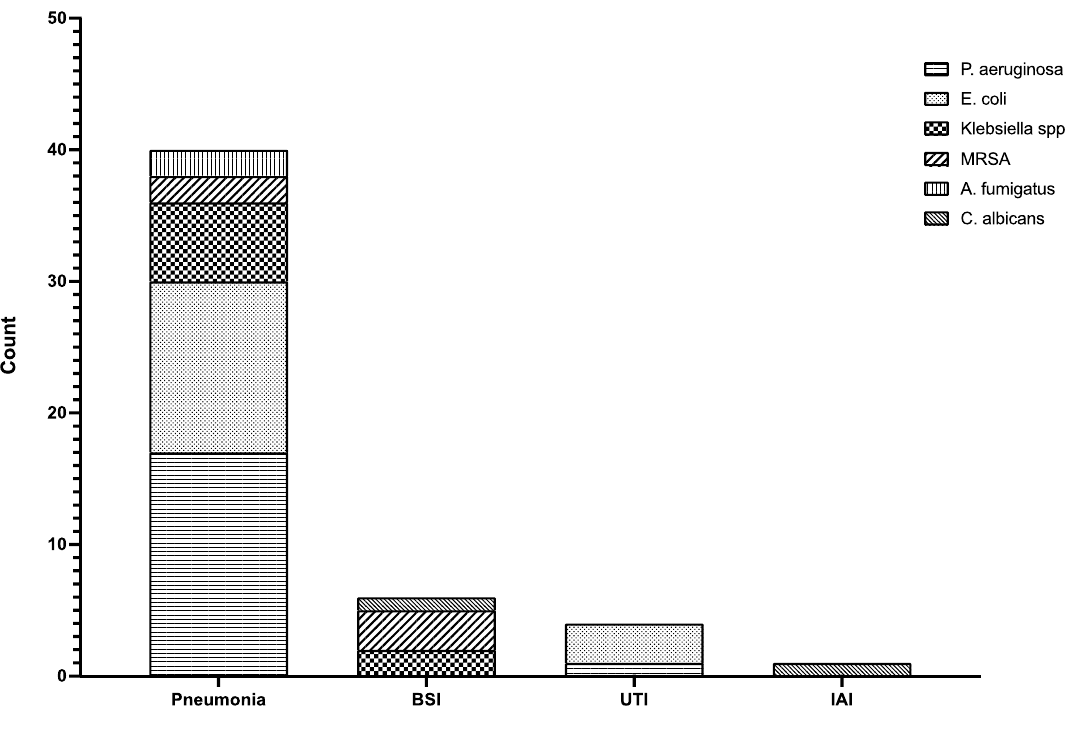
Figure 3. Etiology of HAIs by site of infection. A total of 18 cases of pneumonia were caused by Pseudomonas aeruginosa (horizontal stripes), 13 cases were due to Escherichia coli (sparse points), 6 patients had a Klebsiella spp. (checks) pneumonia, and MRSA (large slant stripes) and Aspergillus fumigatus (vertical stripes) caused 2 cases of pneumonia each. BSIs were caused by Klebsiella spp. (checks) in two cases, MRSA (slant stripes) in three cases, and by Candida albicans (close slant stripes). UTIs were caused by Escherichia coli in three cases and Pseudomonas aeruginosa in one case. One case of IAI was caused by C. albicans . Abbreviations: spp., species plures; MRSA, methicillin-resistant S.